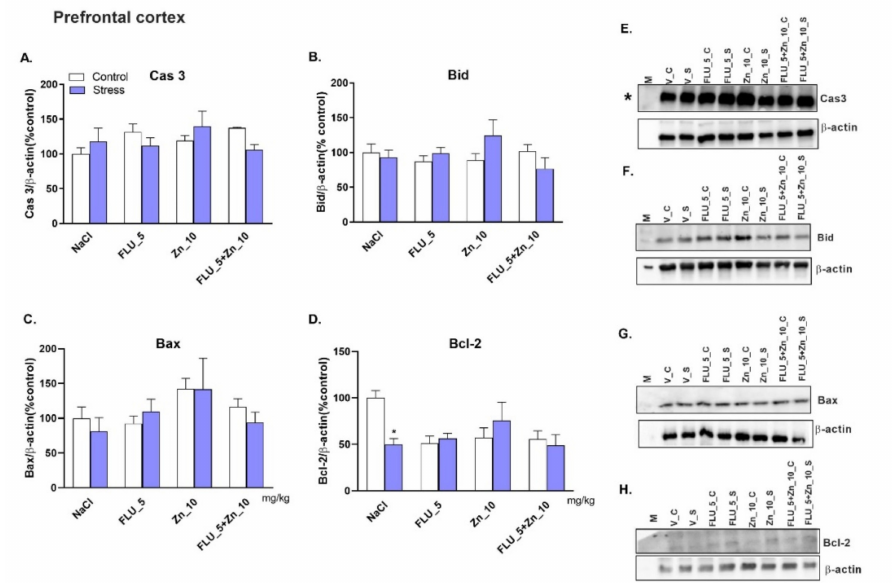
Figure 5. The effect of Zn supplementation and FLU treatment on caspase 3 (Cas3; A ), Bid ( B ), Bax ( C ), and Bcl-2 ( D ) proteins in the PFC of mice subjected to CRS. All data were analyzed by two-way ANOVA and Newman–Keuls multiple comparison test. Values are expressed as mean ± SEM; n = 4–7. * p < 0.05 vs NaCl. ( E – H ) Representative western blots * images from the same membrane (please see Figure